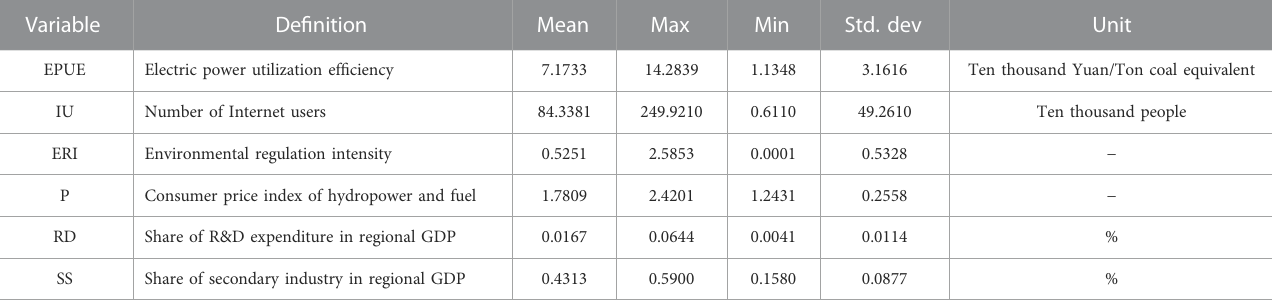
TABLE 2 Statistical description of